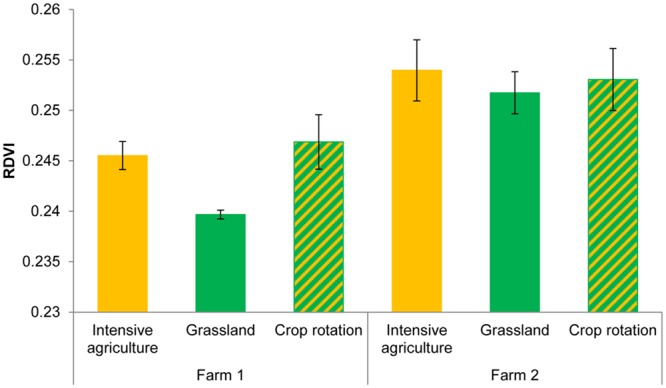
RDVI of Triticum aestivum L. plants growing in the presence of the microorganisms from two farms with three land use types. ANOVA Farm F = 23.08, df1,8
P = 0.001; Field F = 2.23, df2,8
P = 0.17.